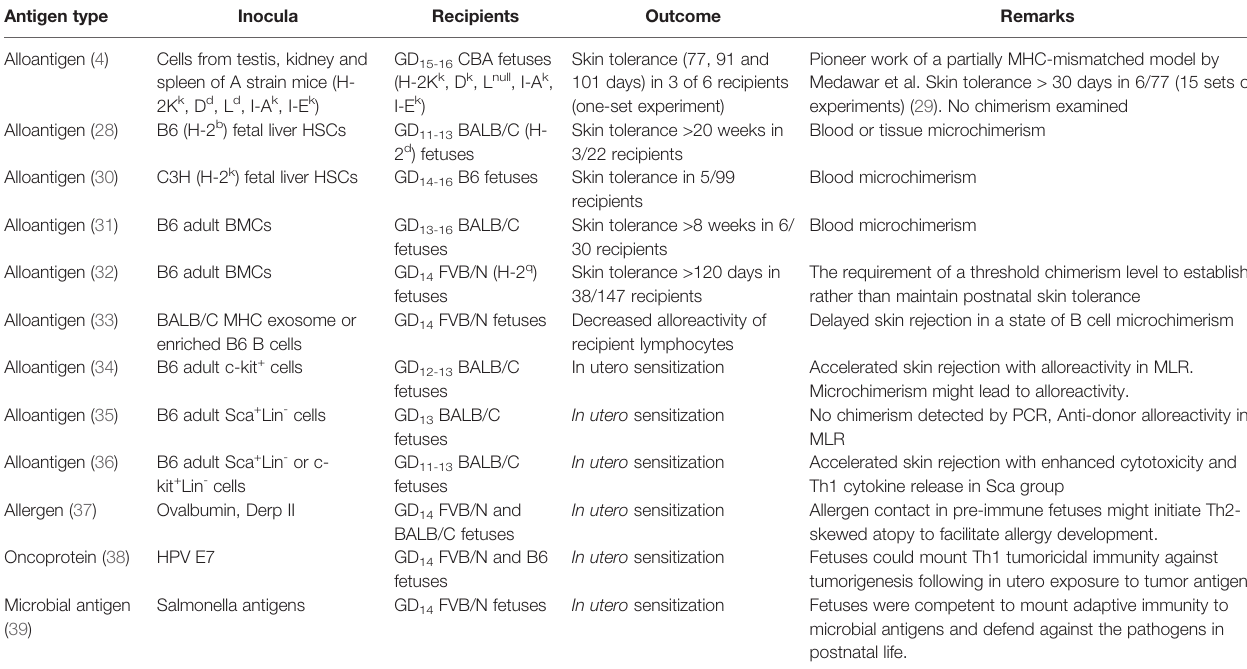
TABLE 1 | Immunological outcome of fetal exposure to foreign antigens in